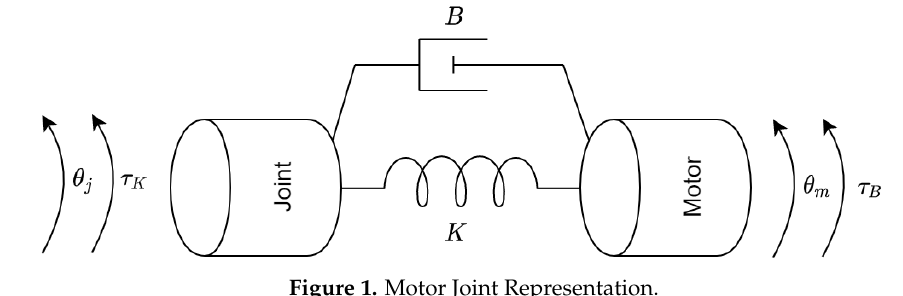
Figure 1. Motor Joint